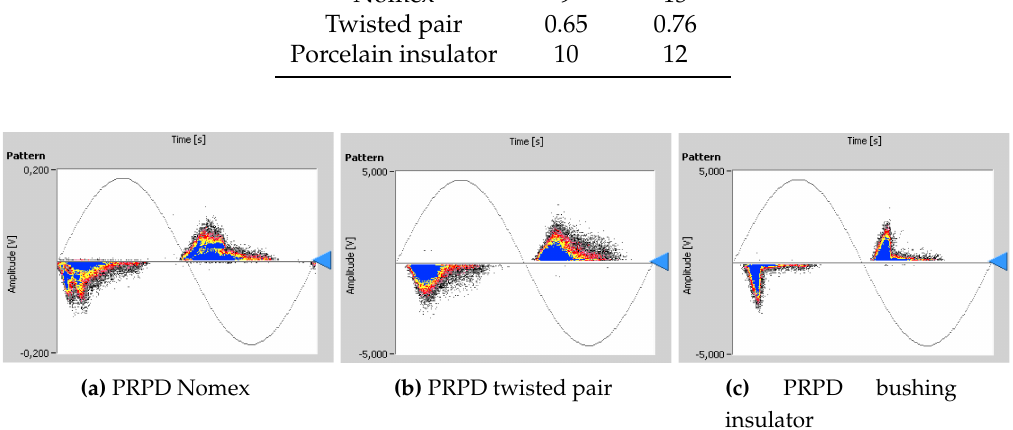
Figure 9. PRPD patterns: ( a ) Internal PD in Nomex 4-3-4 submerged in oil, ( b ) surface PD in twisted pair and ( c ) surface PD in bushing insulator.